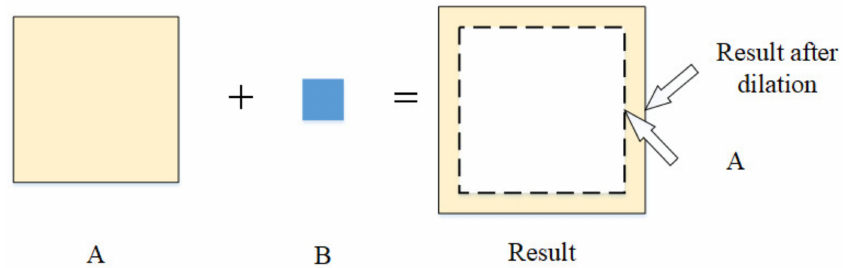
Figure 8. The principle of dilation.